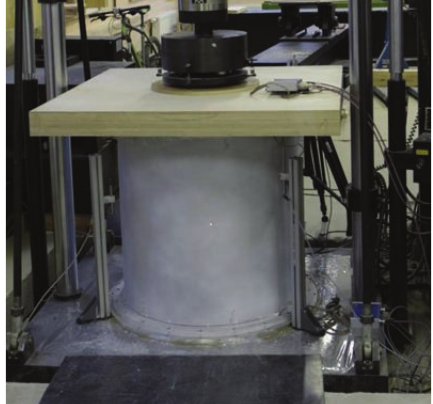
Figure 5: Experimental test setup for compressive loading on SST-2 cylindrical shell (RTU).